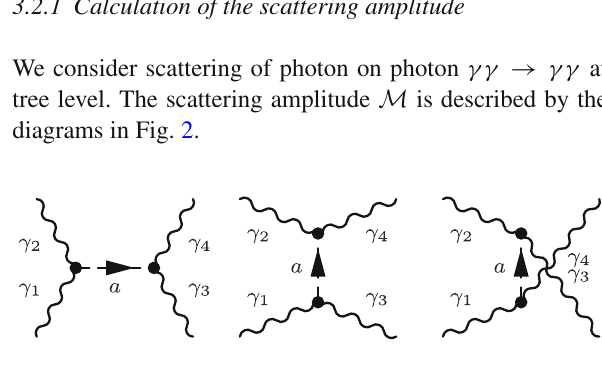
Fig. 2 Feynman diagrams for scattering of photon on photon in axion